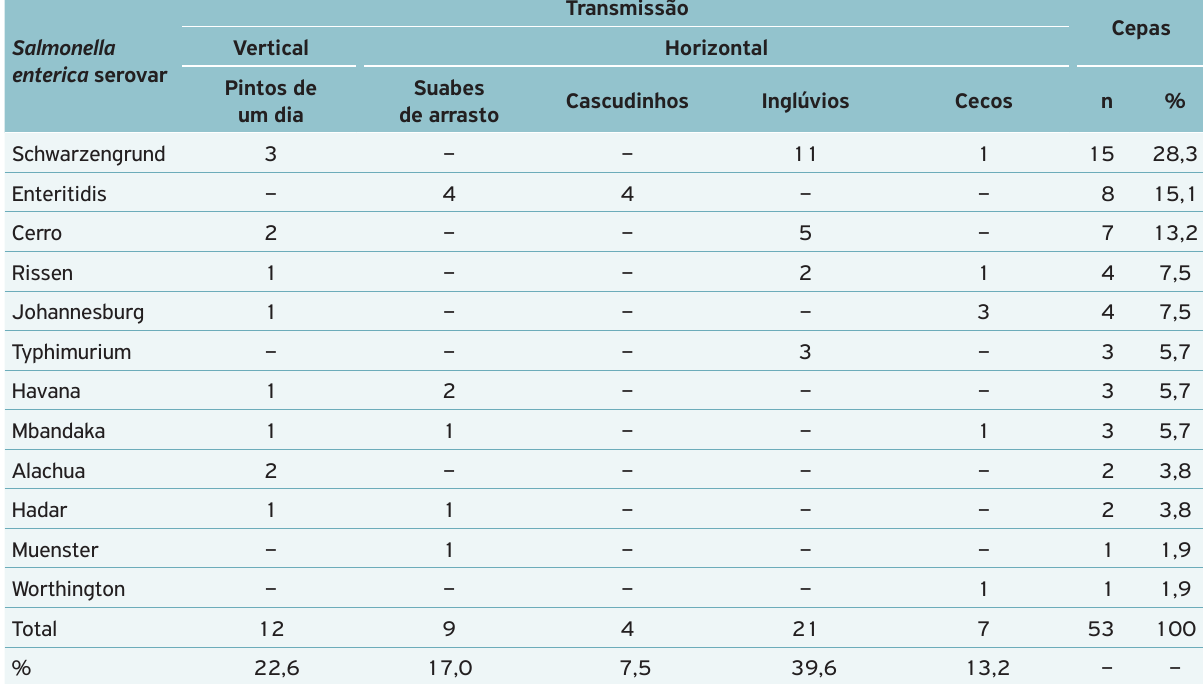
Tabela 2. Frequência dos serovares de Salmonella no fluxo de produção de frangos de corte e no abatedouro.